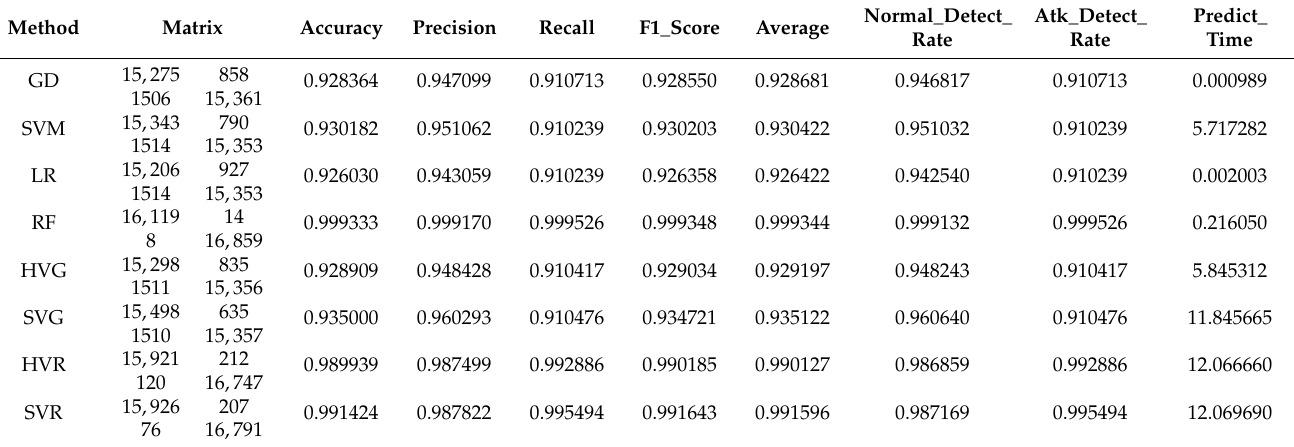
Table 4. Performance indicators for each model of the model selection